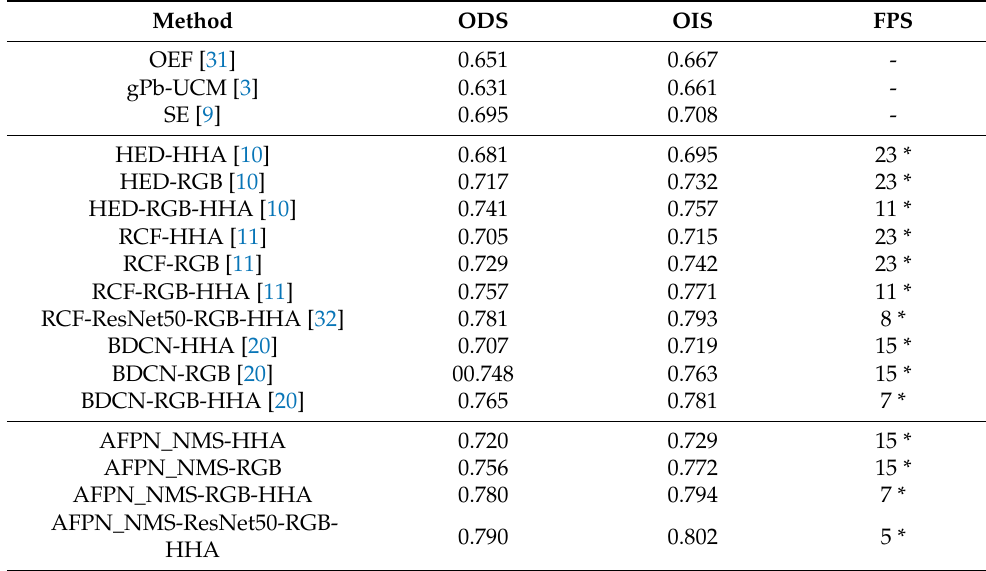
Figure 6. The evaluation results standard NYUDv2 dataset. Table 2. Comparison with recent works on the NYUDv2. * means GPU time.